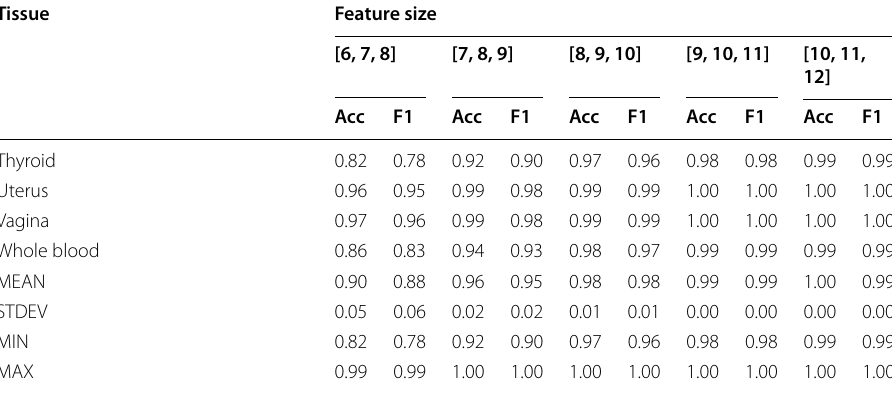
Accuracy indicated by Acc and F1‑Score indicated by F1